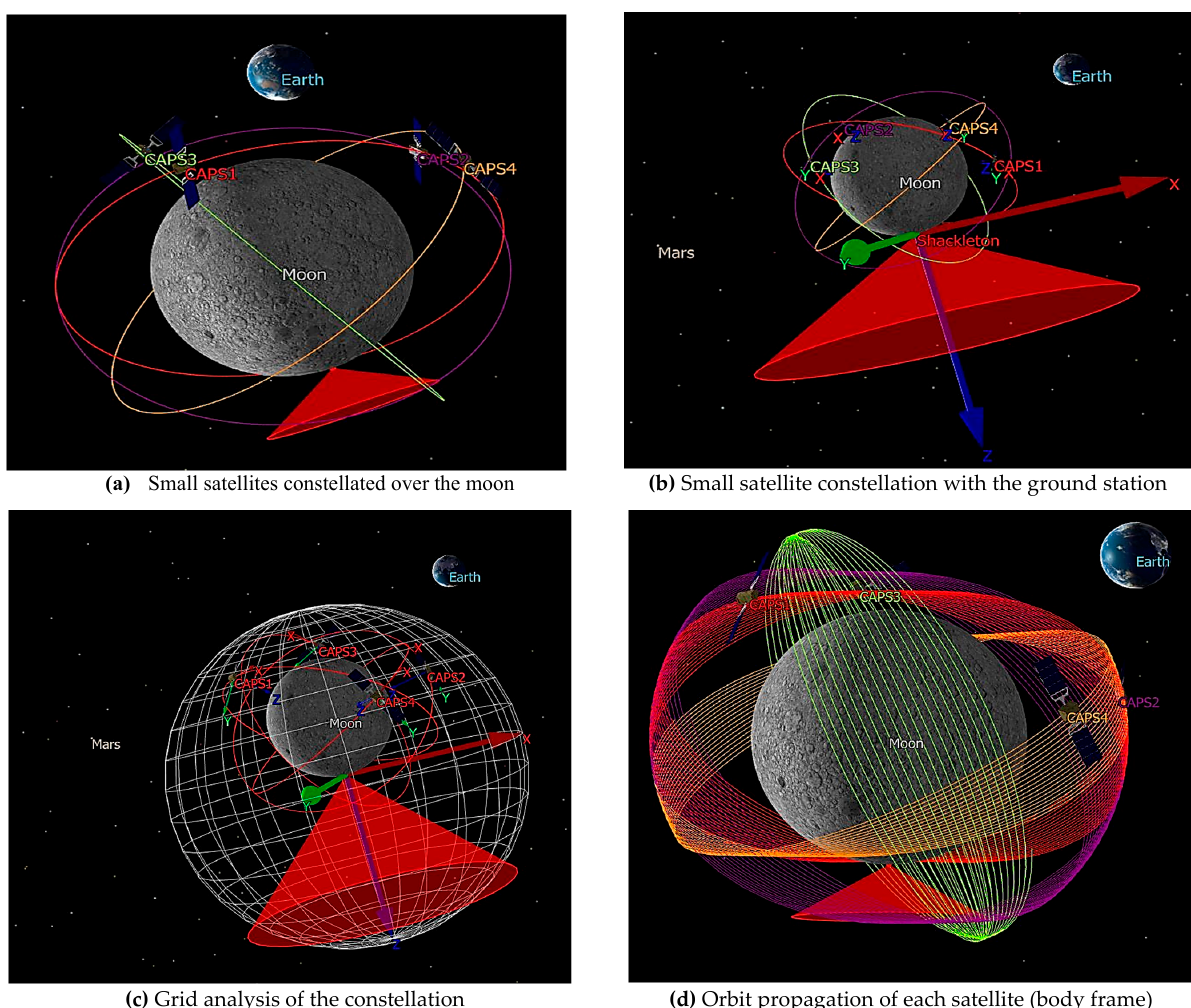
Figure 21. Two-body orientation of the lunar constellation with Shackleton ground station.